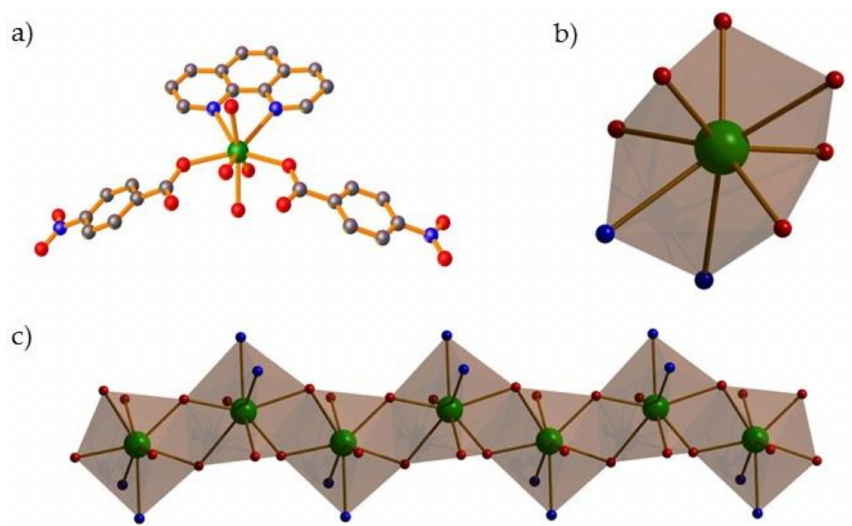
Figure 1. ( a ) Coordination sphere of Tb(III) ion the complex 1 . ( b ) Polyhedron of coordination environment around Tb metal centre. ( c ) The one dimensional chain of complex 1 with Tb(III) ions propagated by water and hydroxyl bridges (Hydrogen atoms were omitted for clarity, colour code: Tb = green, O = red, C = grey, N = blue).